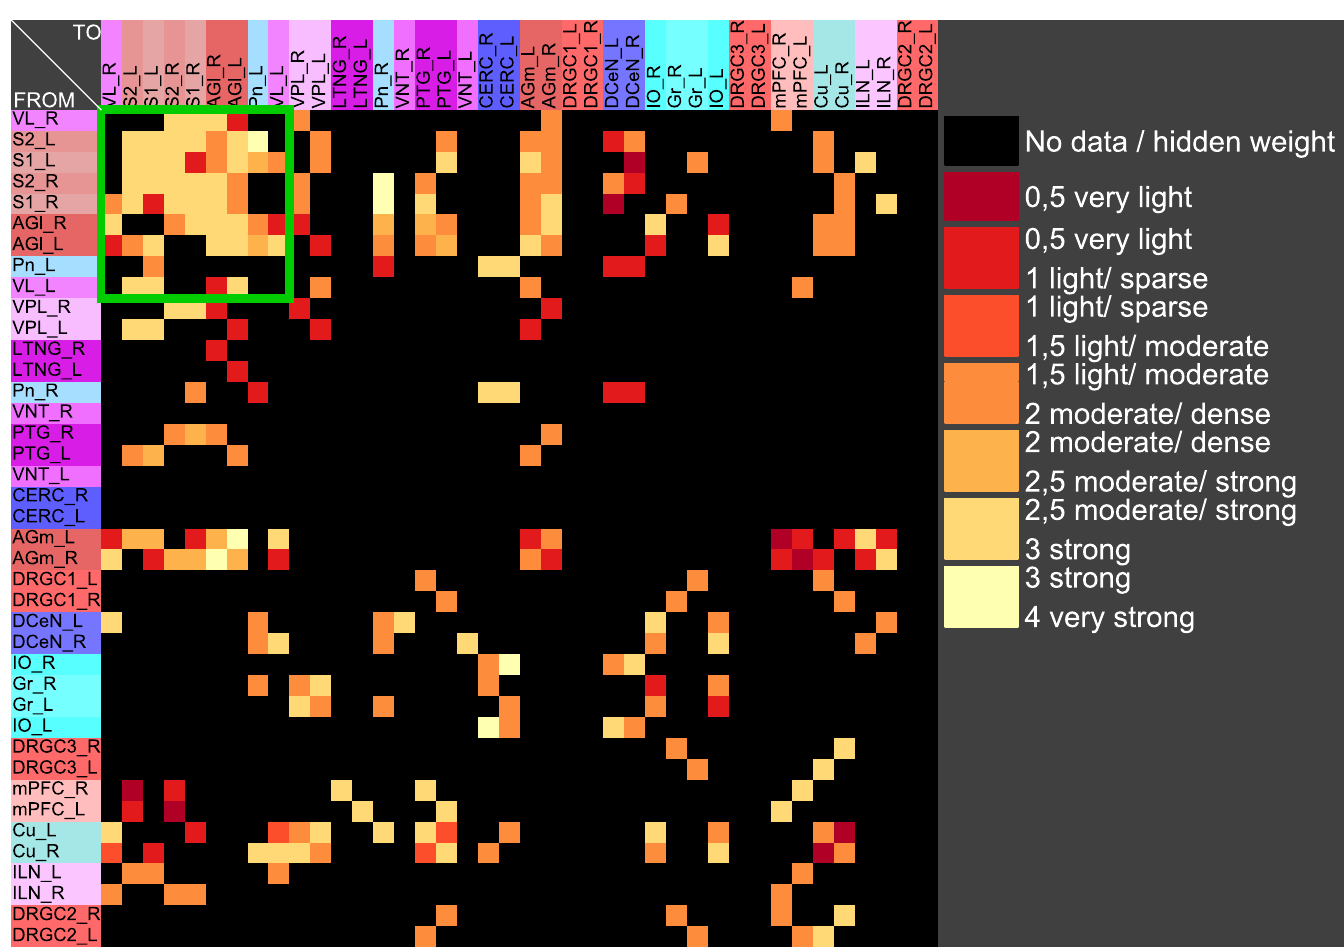
Fig 13. Result of clustering the cross-correlation matrix of a GM process. The somatosensory regions constitute a cluster (green rectangle).